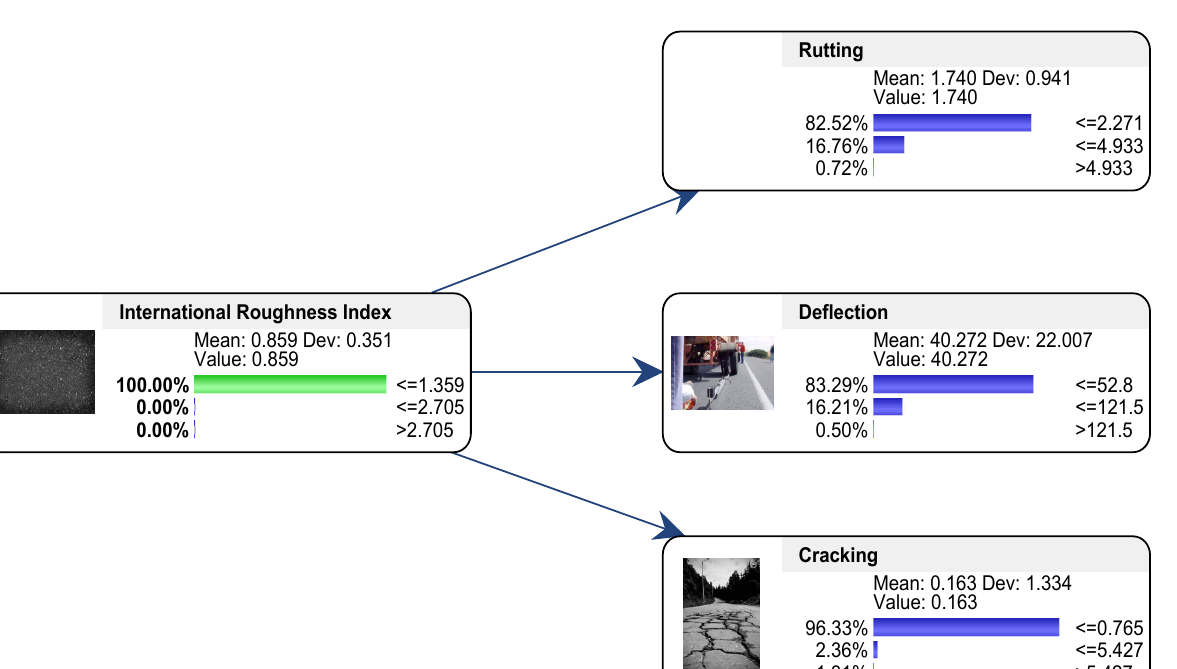
Figure 8. Posterior probability distribution based on likelihood and prior distribution.